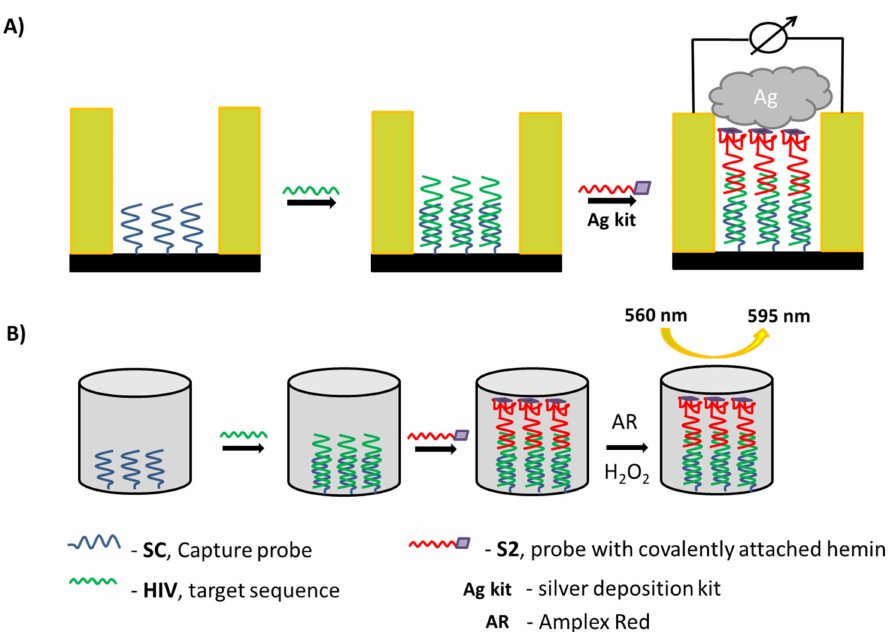
Scheme 1. Scheme of HIV DNA sequence detection using electric chip, hybridization with a “sand- wich” approach, and silver deposition catalyzed by the covalent DNAzyme ( A ) and scheme of HIV DNA detection using “sandwich” covalent DNAzyme assay using streptavidin-modified mi- croplates ( B ).